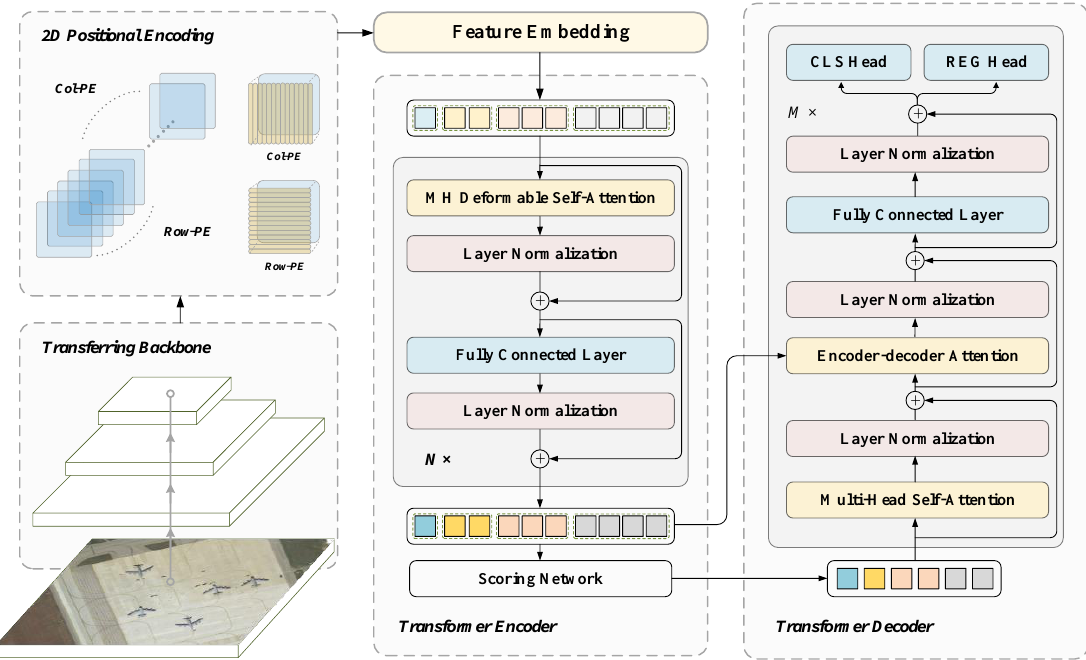
Figure 2. The framework of the proposed TRD.